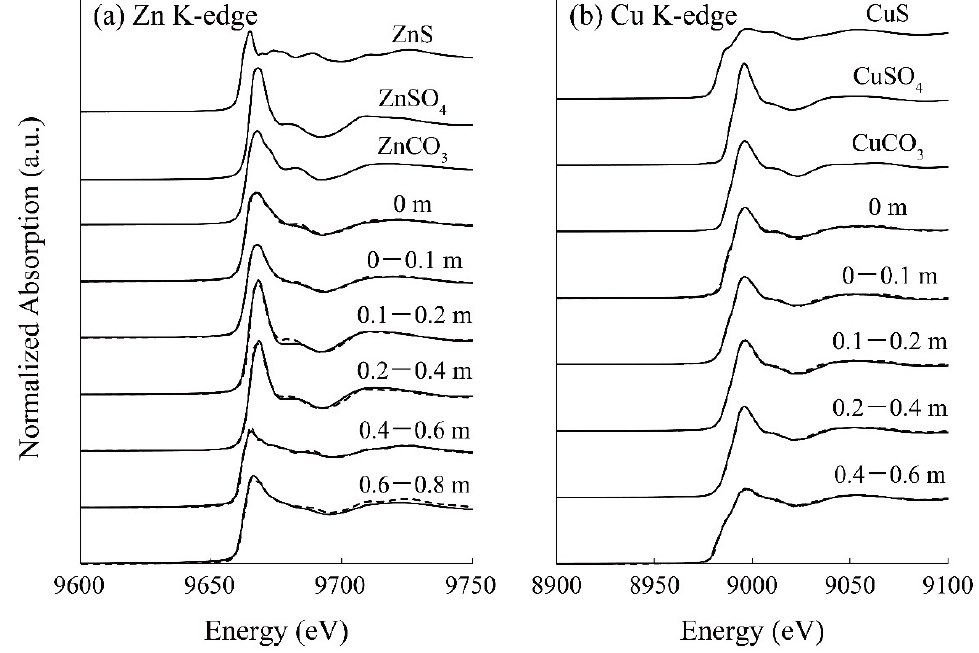
Figure 5. ( a ) Zn K-edge and ( b ) Cu K-edge XANES spectra of reference samples and the solid residue taken from the column at various depths. The dotted lines indicate the LCF fitting results. Table 2. LCF fitting results against the XAFS spectra of column residues taken at various depths. Zn K-Edge Cu Depth (m) Depth (m)